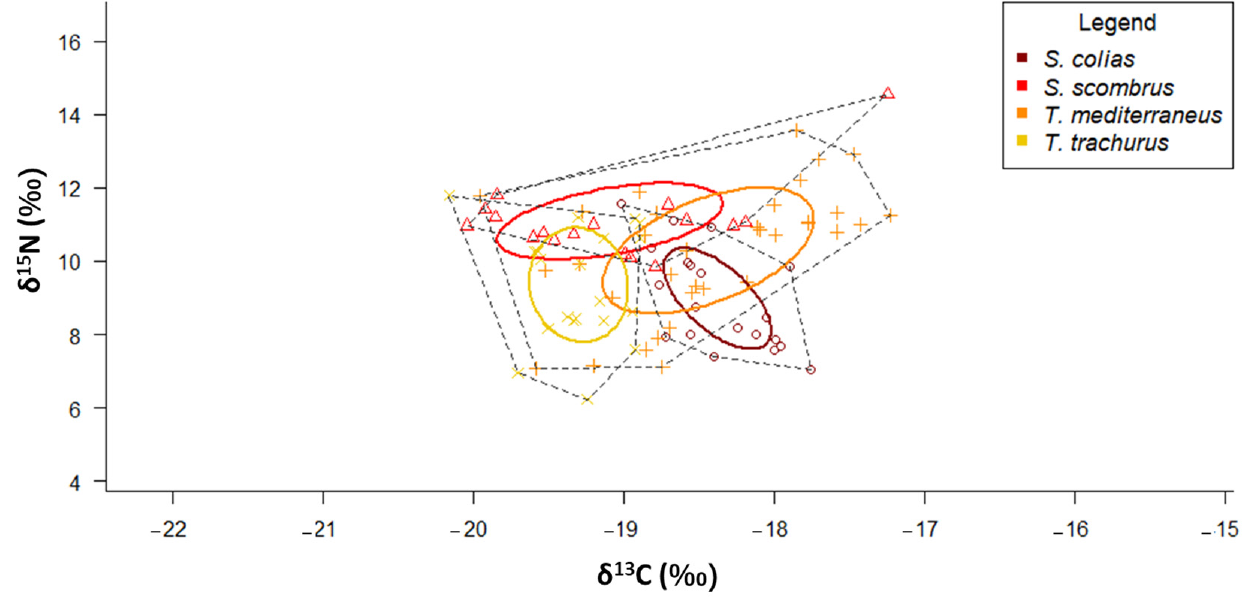
Figure 6. δ 13 C- δ 15 N scatterplot with standard ellipses corrected for small sample size population (SEA C, ‰ 2 ) overlaid for the specimens of the four “ancillary” species collected in the Adriatic Sea.